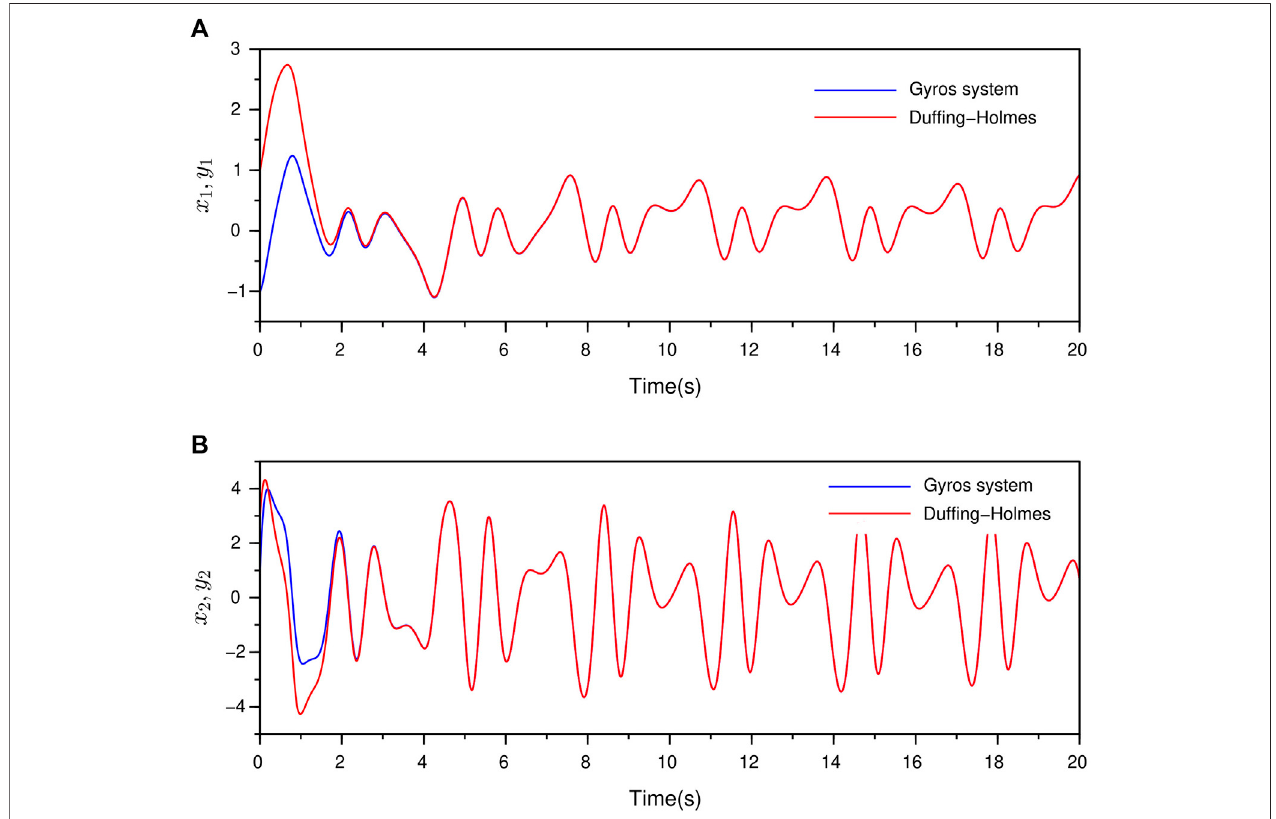
FIGURE 2 | Synchronization between the Gyros and the Duf fi ng-Holmes systems in Example 1 by ANFTSM controller (A) the synchronization between x 1 and y 1 (B) the synchronization between x 2 and y 2 .